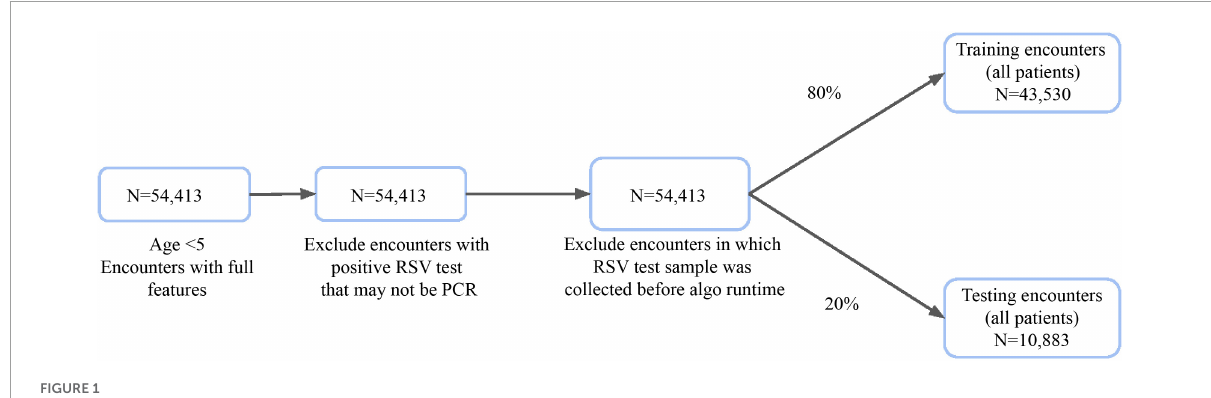
FIGURE1 Inclusion criteria for training and testing datasets of patient hospital encounters for algorithm development.